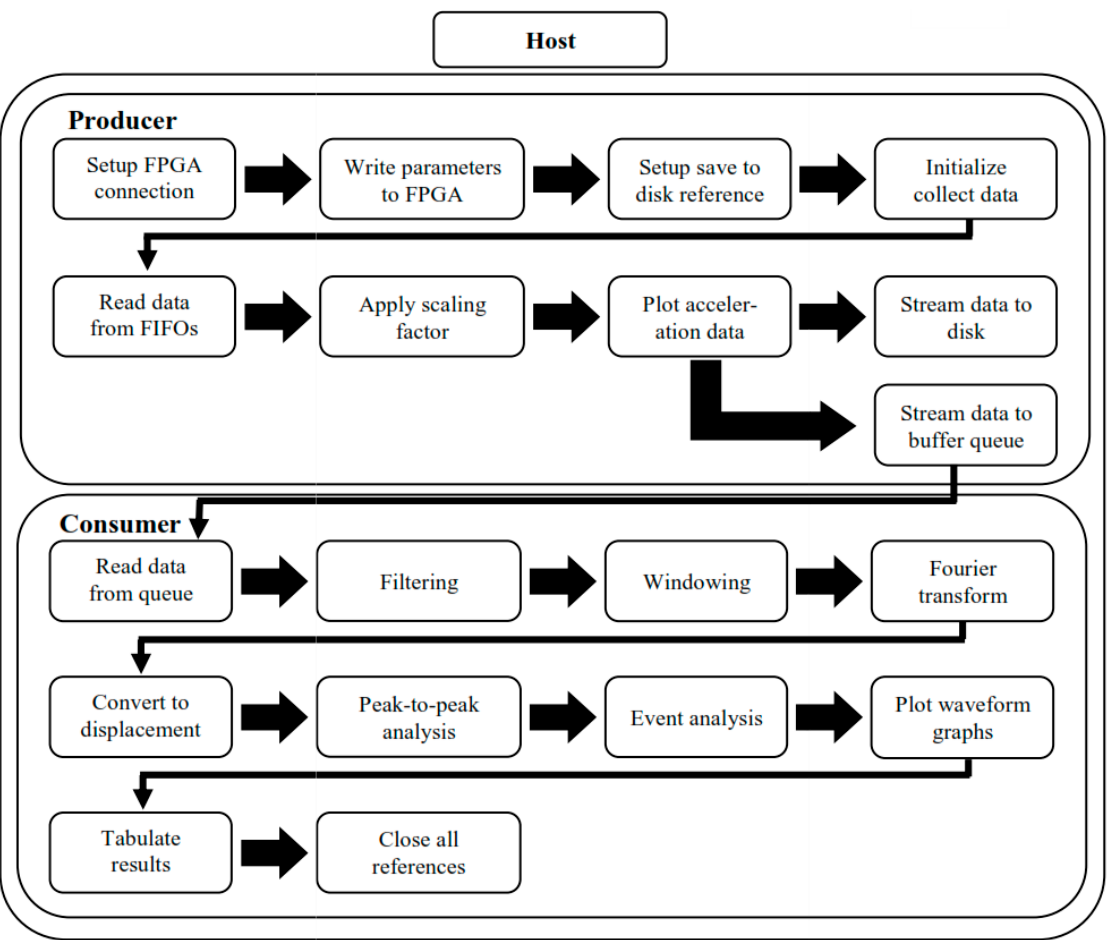
Figure 3. Programme function flowchart of the host script, which is executed on the main computer and communicates and reads the accelerometer data from the target VI on the cRIO.